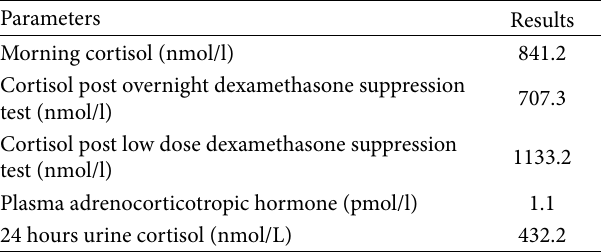
Table 1: Hormonal work up for Cushing’s syndrome.